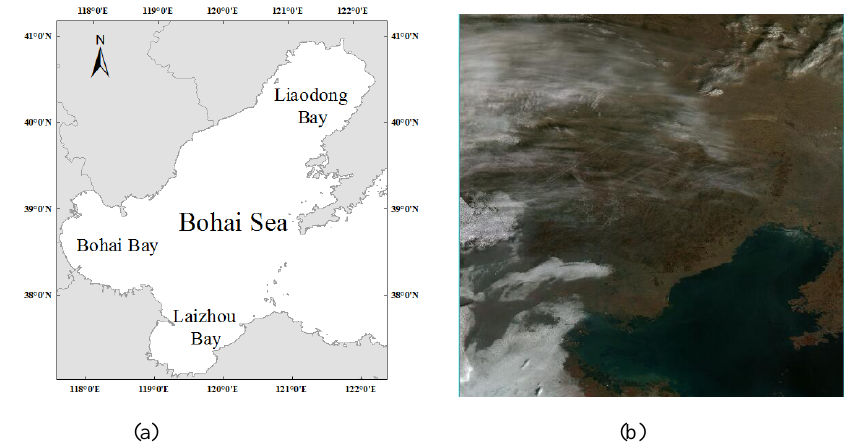
Figure 1: The study area for this study (a) and the GF4 image (Red: B3, Green: B4, and Blue: B5) (b) 2. DATA